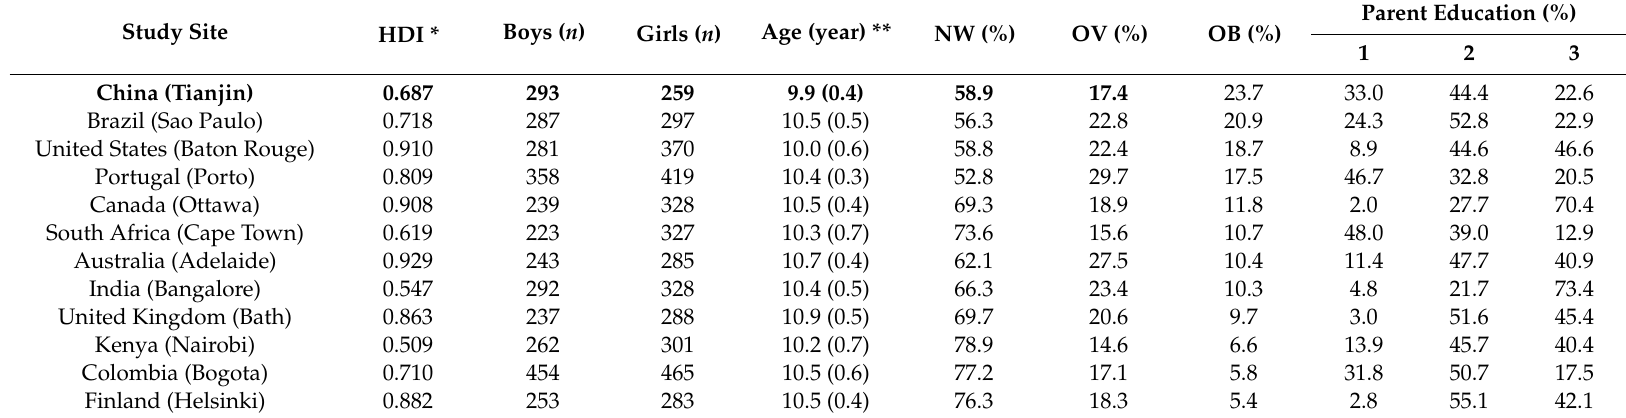
Table 1. Descriptive characteristics of the study sample from the International Study of Childhood Obesity, Lifestyle and the Environment